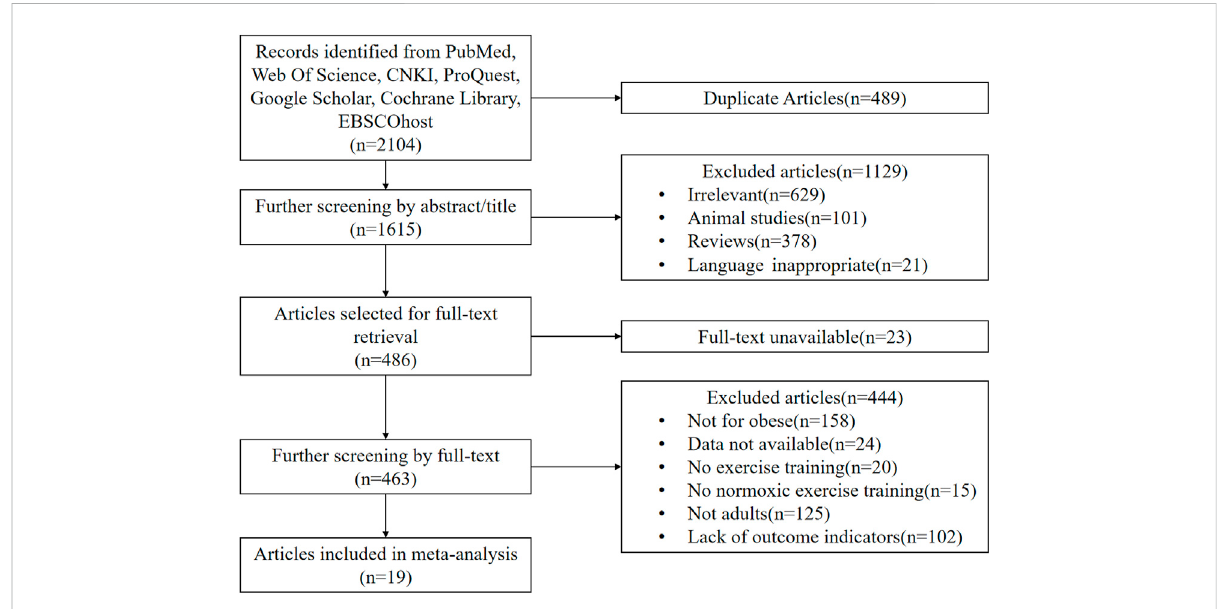
FIGURE 1 Flow diagram of the process of article selection.